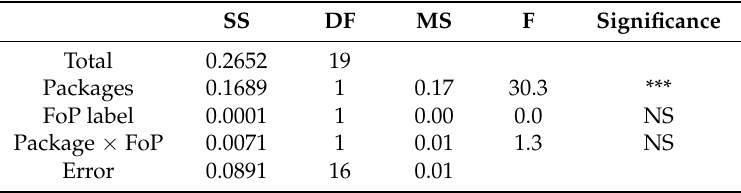
Table 1. Analysis of variance Dunedin, stores as replications.